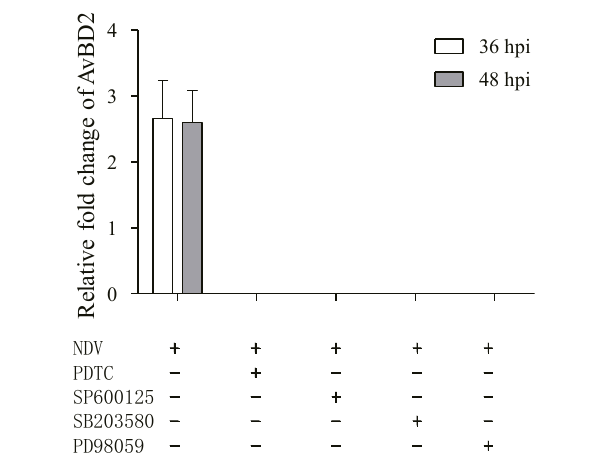
FIGURE 4 | Inhibitors of MAPK/NF- κ B inhibit AvBD2 expression mediated by NDV. CEFs were pre-treated with 50 µ M PDTC (NF- κ B inhibitor), 50 µ M